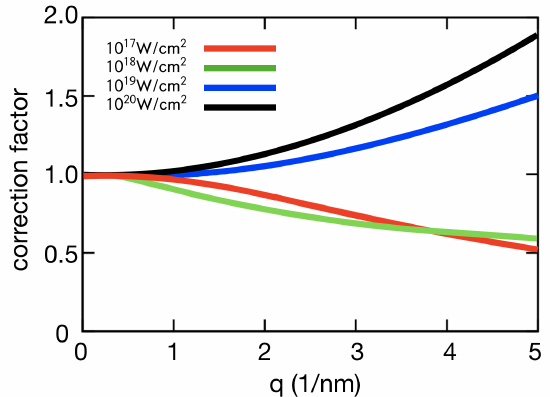
Figure 2. Correction factor. For systems far from thermal equalibrium, the Debye–Waller factor does not model the global damage well. The correction factor, as presented in Barty et al. [7], includes both the non-thermal heating of the system and atomic form factors modified due to the ionization. Data shown are based on plasma simulations similar to those in Caleman et al. [11], with the following beam parameters: pulse intensities 10 17 –10 20 W/cm 2 , pulse length 500 fs, photon energy 6